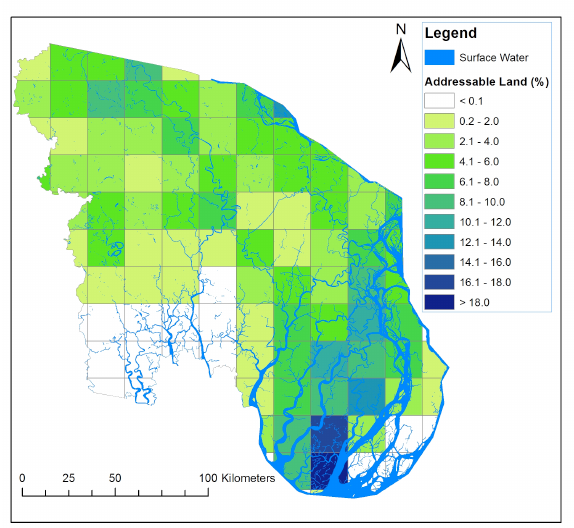
Figure 4: Addressable land suited for sustainable intensification in the delta region of Bangladesh expressed as percentage of total land area in each grid cell. Land belonging to the Non- suitable class due to high salinity levels or belonging to the Low and Very Low Land classes was